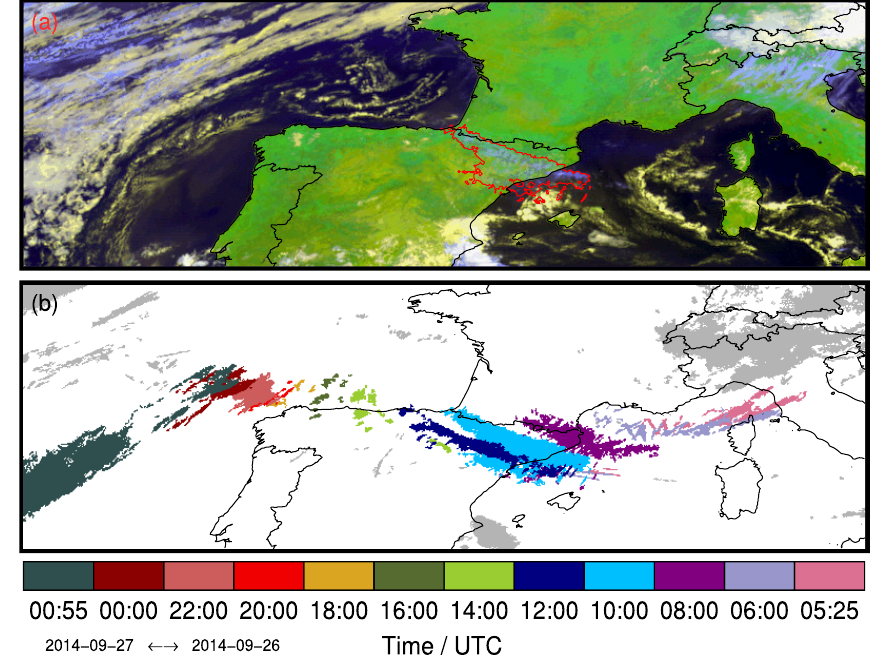
Figure 13. (a) False colour RGB composite on 26 September 2014 at 10:00UTC. The red contour of the CiPS cirrus cloud mask shows the outline of the cirrus cloud, whose life cycle is analysed. The orographic cirrus, from which the tracked cirrus originates, is clearly seen south of the Alps. (b) The path and temporal evolution of the cirrus cloud as it is tracked backward and forward in time with a temporal resolution of 120min. The light grey colour shows all cirrus clouds present at 05:25UTC that were not tracked in order to understand the origin of the analysed cirrus